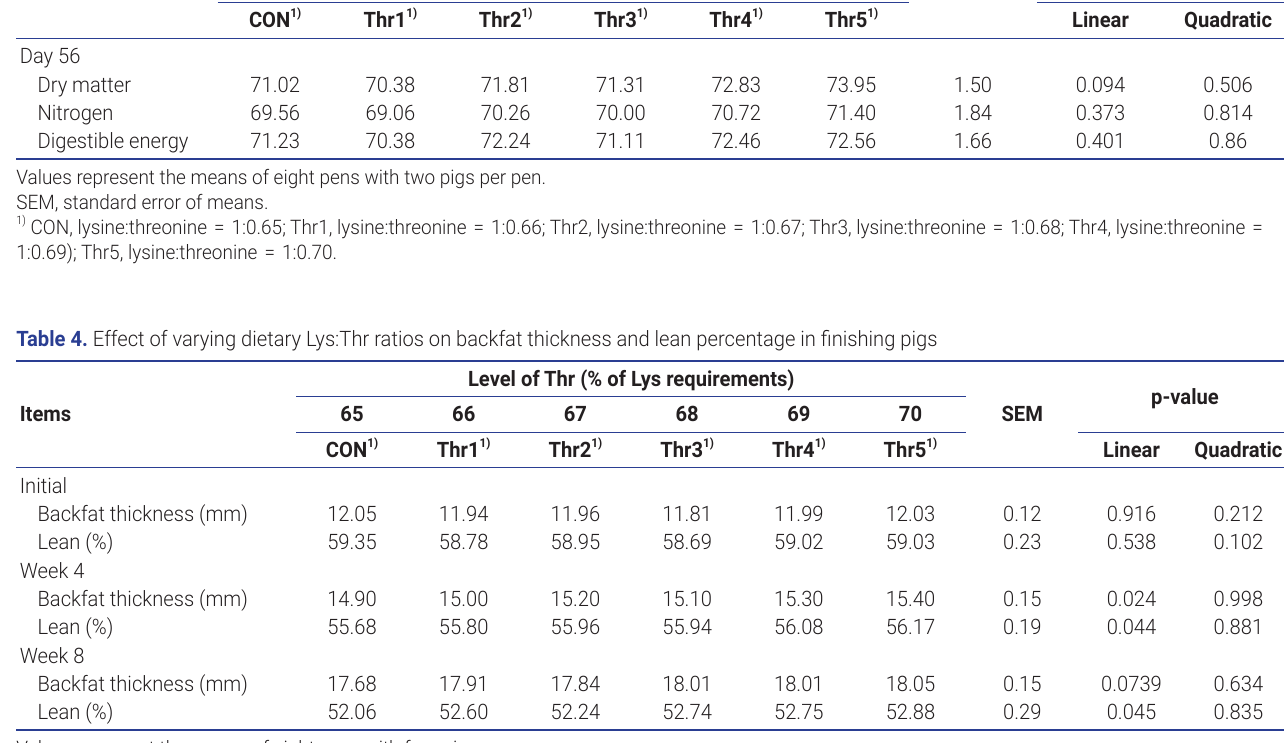
Table 3. Effect of varying dietary Lys:Thr ratios on nutrient digestibility in finishing pigs Level of Thr (% of Lys requirements) Items (%)